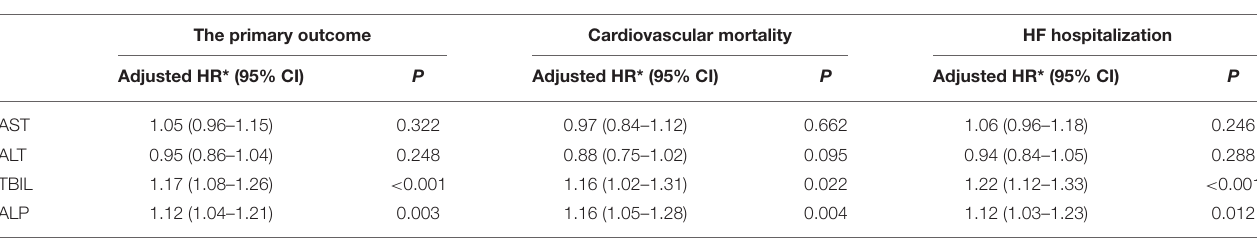
TABLE 4 | Associations of liver function tests and clinical outcomes.